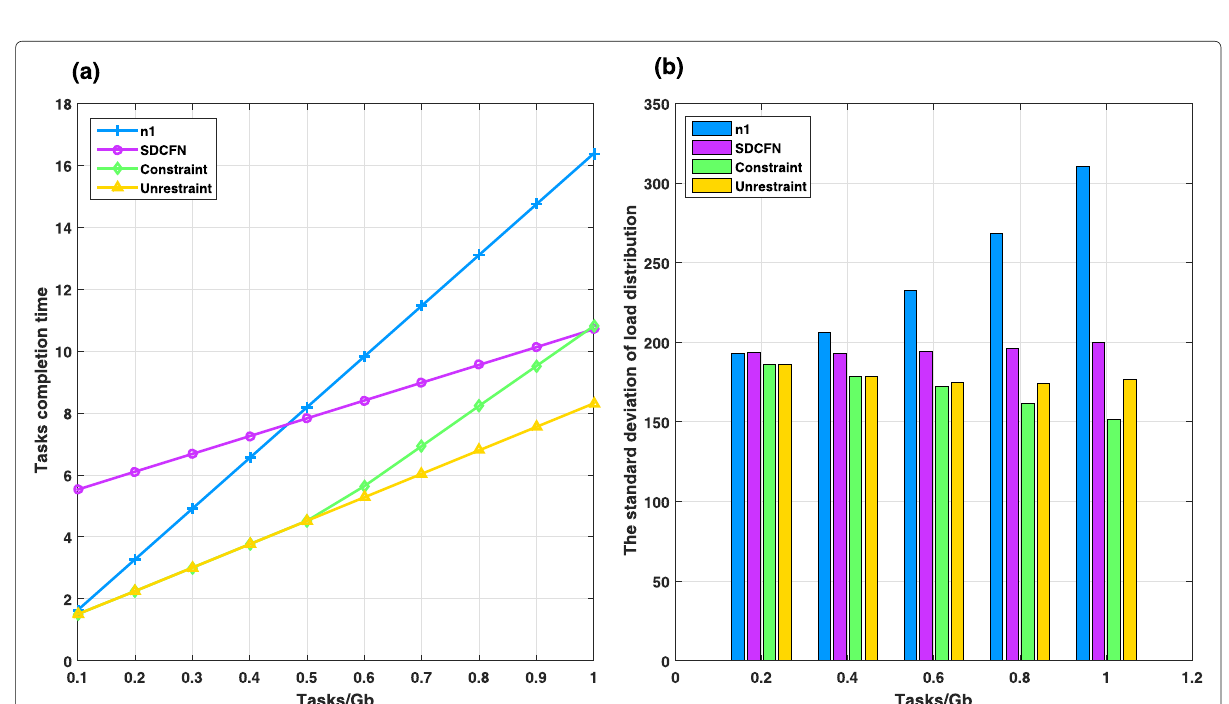
Fig. 5 a Effects of different strategies on task completion time. b Effects of different strategies on standard deviation of load